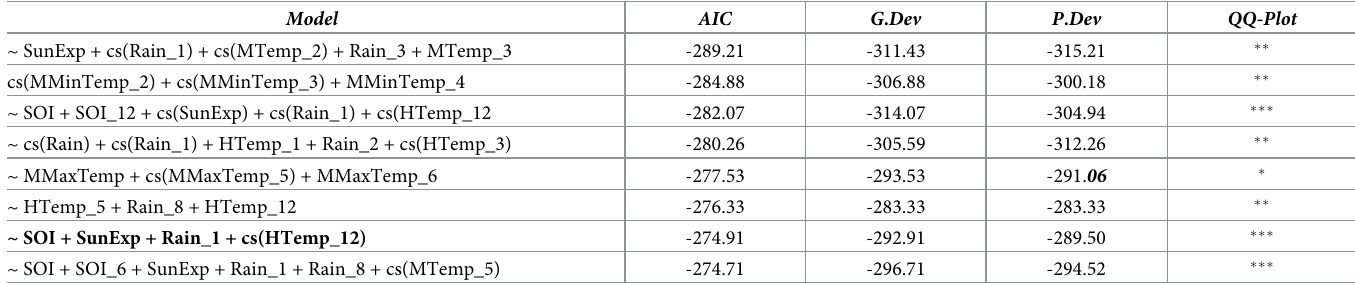
Table 3. Continuous models explaining flowering intensity of Jacaranda trees based on a beta distribution in Melbourne, Perth, Sydney, Parramatta and Penrith between 2009–2019. The number of asterisks indicate model fit ( � Low fit, �� Moderate fit, ��� Good fit). Bold letters outline the best models which had the best distribution fit, the least number of covariates, and the lowest Akaike International Criterion (AIC) and both global and Partial deviance (G.Dev and P.Dev, respectively). The explana- tory variables include Mean Minimum Temperature (MMinTemp), Mean Maximum Temperature (MMaxTemp), Highest Temperature (HTemp), Mean Temperature (MTemp), Rainfall (Rain) and Sun Exposure (SunExp) recorded per month at each weather station, as well as the monthly Southern Oscillation Index (SOI). The number after the variable refers to number of months prior (lag) the variable was associated to Jacaranda flowering, and cs indicates smooth variables.